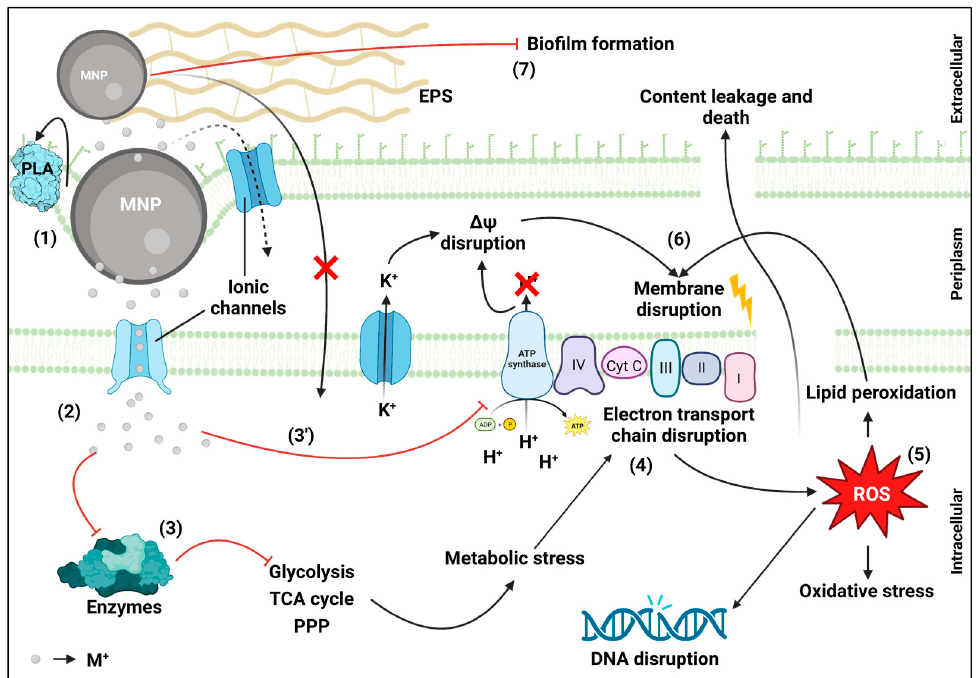
Figure 2. Metal nanoparticles antimicrobial mechanisms. (1) MNPs interaction with the outer membrane leading to PLA activation, phospholipid hydrolysis and formation of pores; (2) M + release into the periplasm and diffusion to cytoplasm through ionic channels; (3) enzyme inhibition from interaction with M + leading to metabolic stress induction; (3 ′ ) respiratory chain disruption by ATPase disturbance (direct disruption); (4) respiratory chain indirect disruption; (5) ROS content increase resulting in DNA disruption and oxidative stress induction; (6) membrane disruption from ROS-induced lipid peroxidation resulting in the formation of pores and consequent cell content leakage leading to cell death; (7) MNPs interaction with EPS hindering biofilm formation. PLA: outer membrane phospholipase; TCA cycle: Tricarboxylic acid cycle; PPP: Pentose phosphate pathway; ROS: reactive oxygen species. Created with BioRender.com.